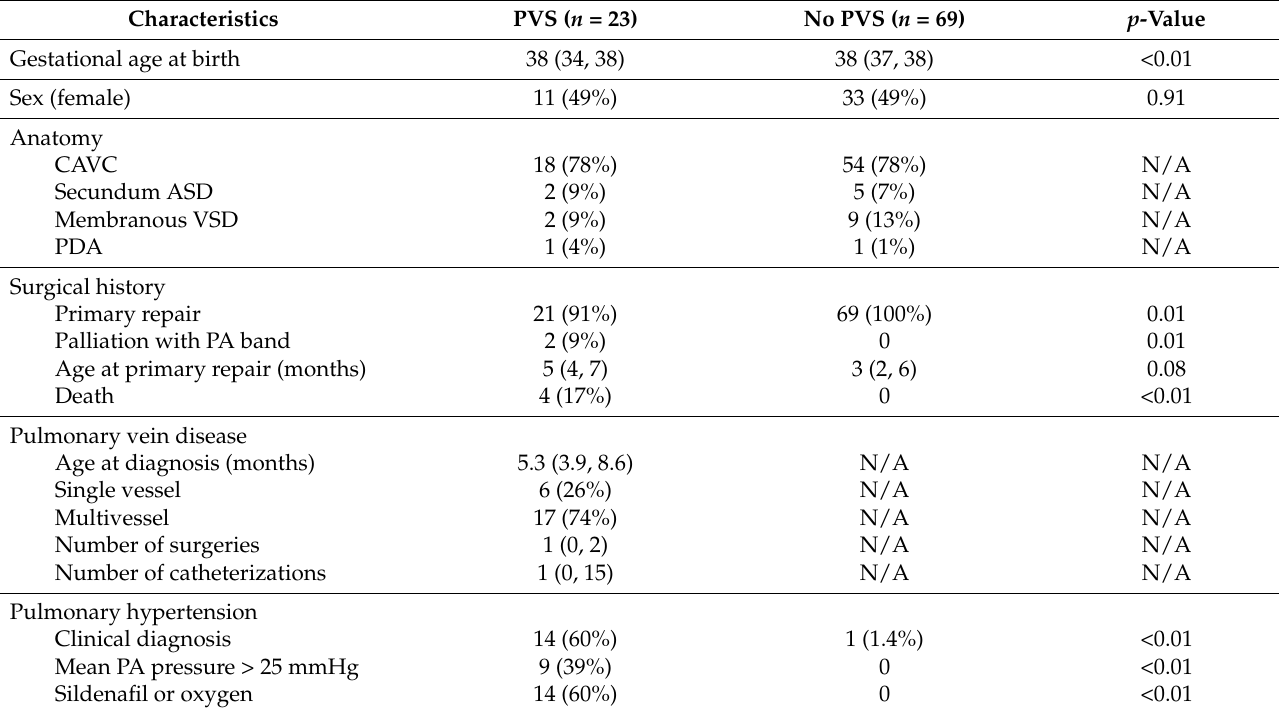
Table 1. Patient